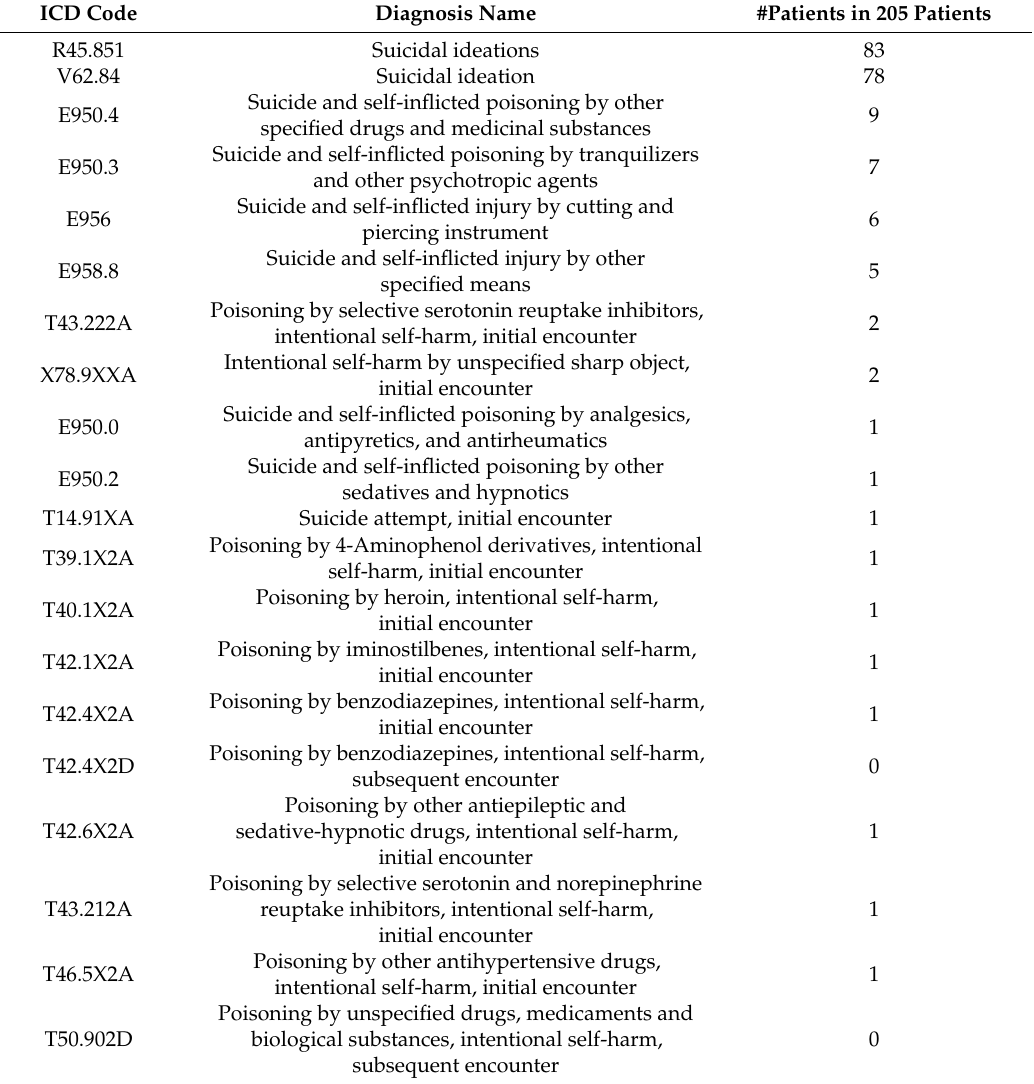
Table A1. Suicide-Related